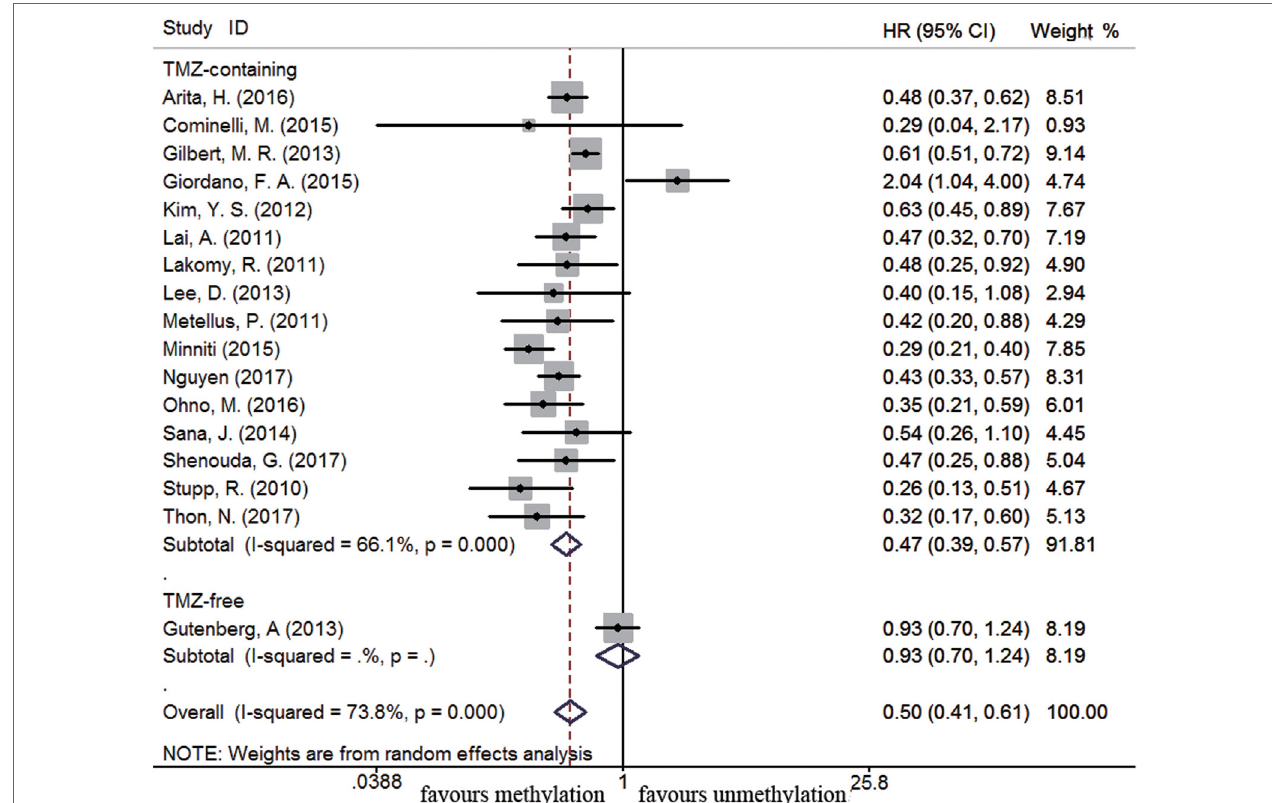
FiGURe 5 | Calculated HRs and 95% CIs for the relationship between methylation and PFS benefit from TMZ-containing or TMZ-free therapy in newly diagnosed GBM patients (methylated vs. unmethylated